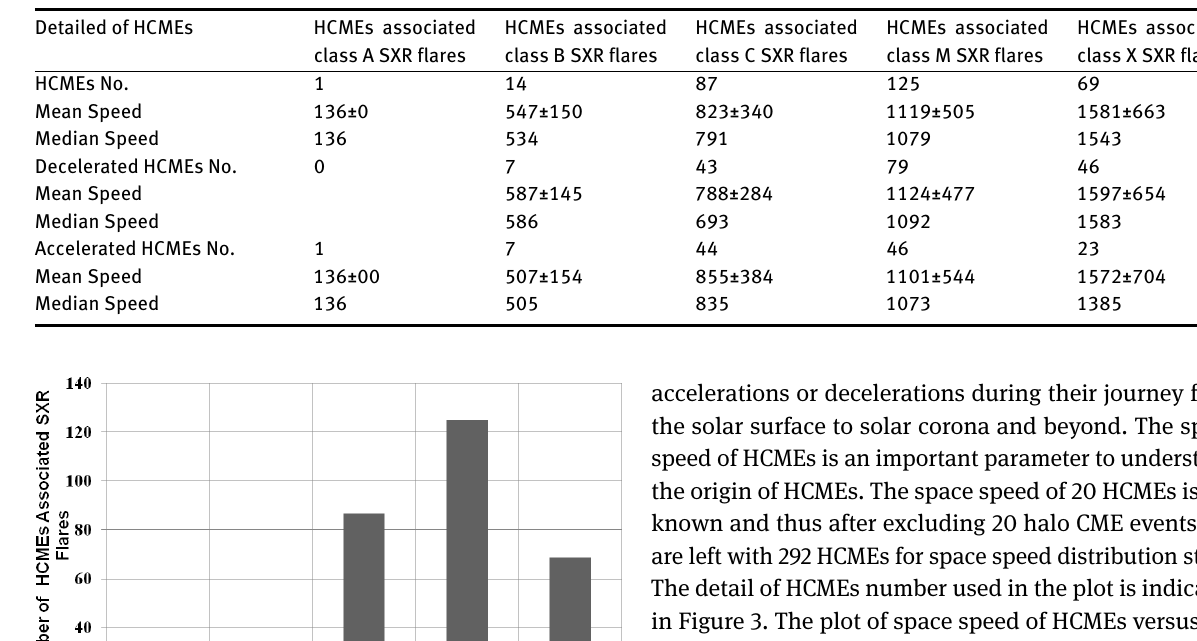
Table 2. Relation between Speed of HCMEs and Class of SXR Flares.